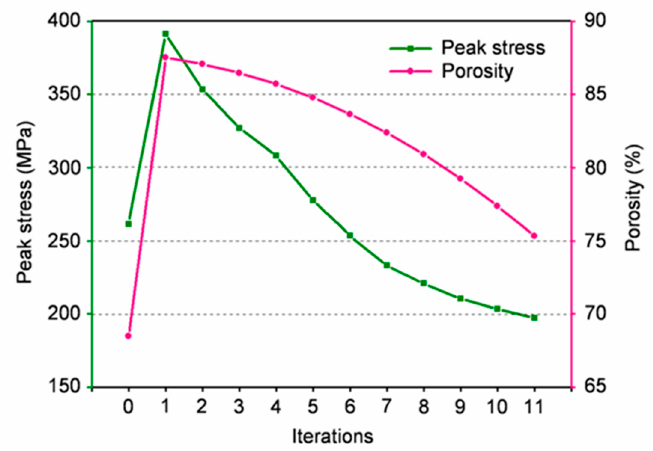
Figure 10. Variation of peak stress and porosity during the iteration process.